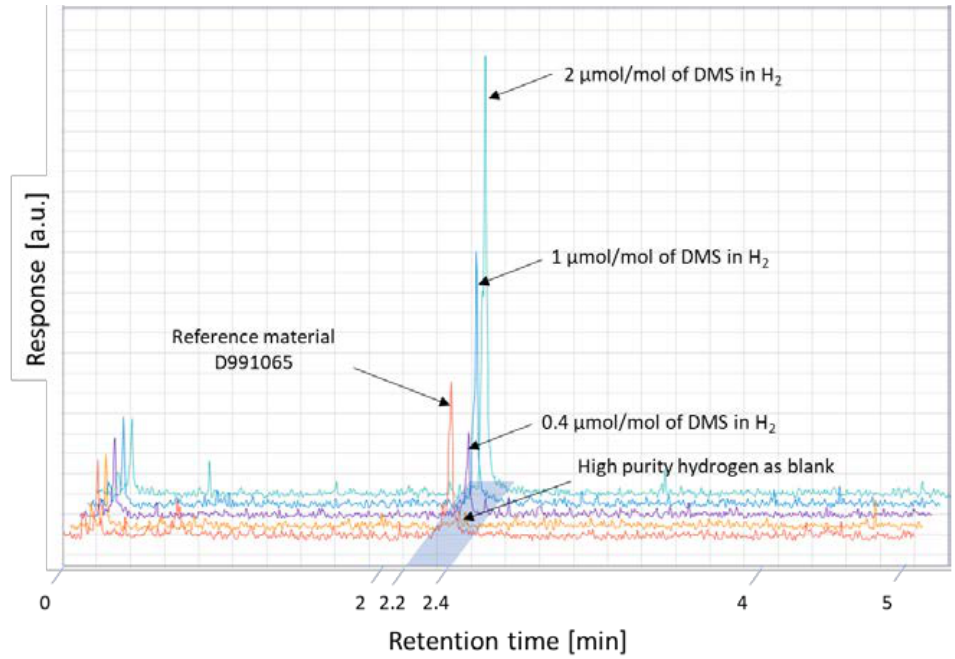
Figure 2. Gas chromatogram of total sulphur in hydrogen at nmol/mol to µmol/mol using the method developed in this article. The five chromatograms presented are three dynamic dilution points (0.4; 1; 2 µmol/mol), a high purity hydrogen as blank, and the results from reference materials at 0.8 µmol/mol (cylinder D991065). The total sulphur retention time is between 2.2–2.4 min.